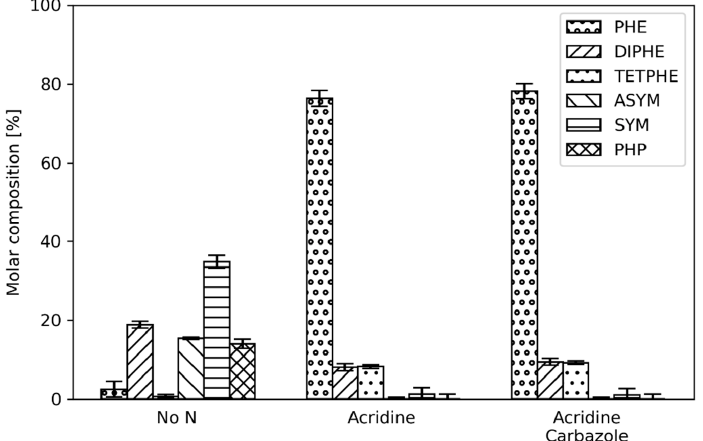
Figure 9. Phenanthrene product distribution in the presence of 2.4 mmol/dm 3 acridine and the combination of acridine and carbazole (2.4 mmol/dm 3 of each, i.e., 4.8 mmol/dm 3 in total) at a reactor temperature of 300 °C.